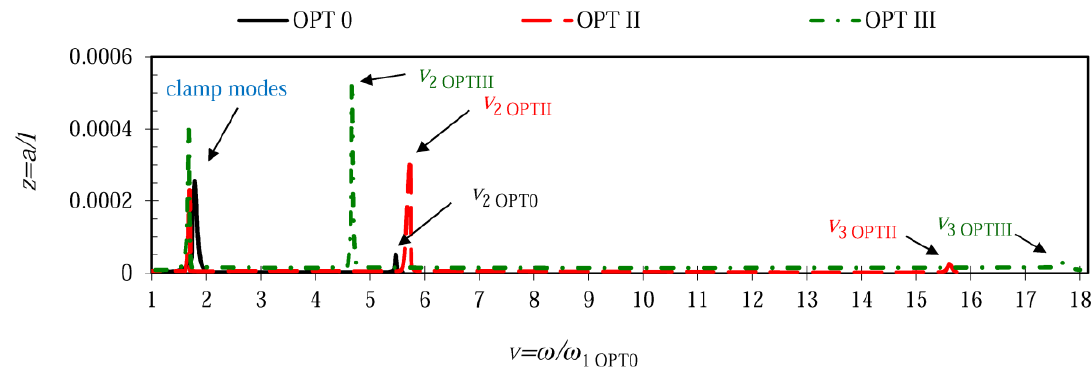
Figure 8. Frequency responses of different microcantilever configurations when the rigid stopper is located at x / l = 0.87 ≈ 0.9.